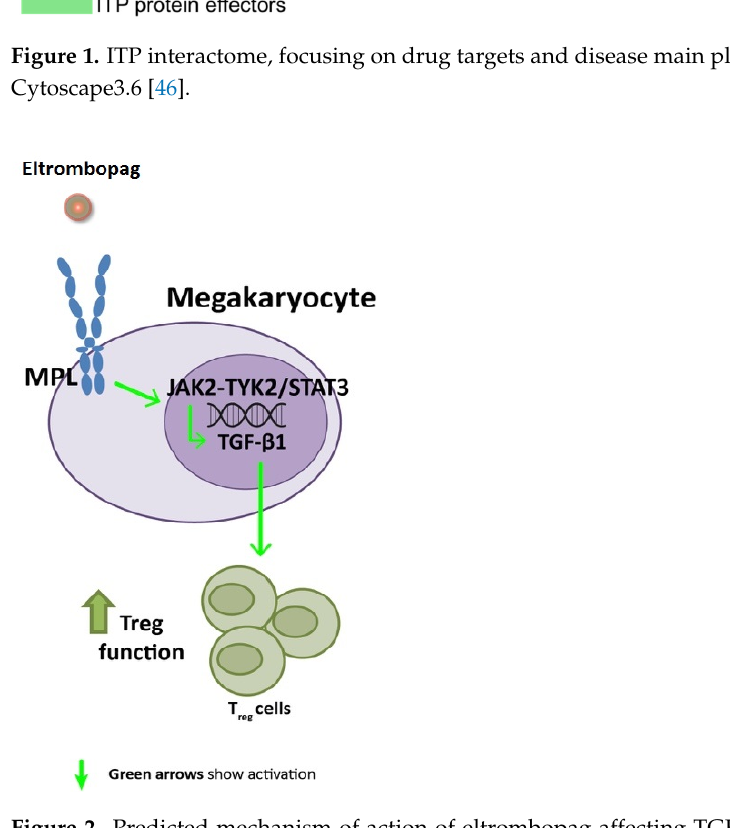
Figure 2. Predicted mechanism of action of eltrombopag affecting TGF- β expression in primary immune thrombocyto- penia megakaryocytes (or other cell types). Model path outputs can be found in Supplementary Figure S2 (A) and scien- tific literature supporting the predicted mechanisms can be found in Supplementary Table S5. MPL: thrombopoietin re- ceptor; TGF- β : transforming growth factor-beta. MPL: thrombopoietin receptor; TGF- β : transforming growth